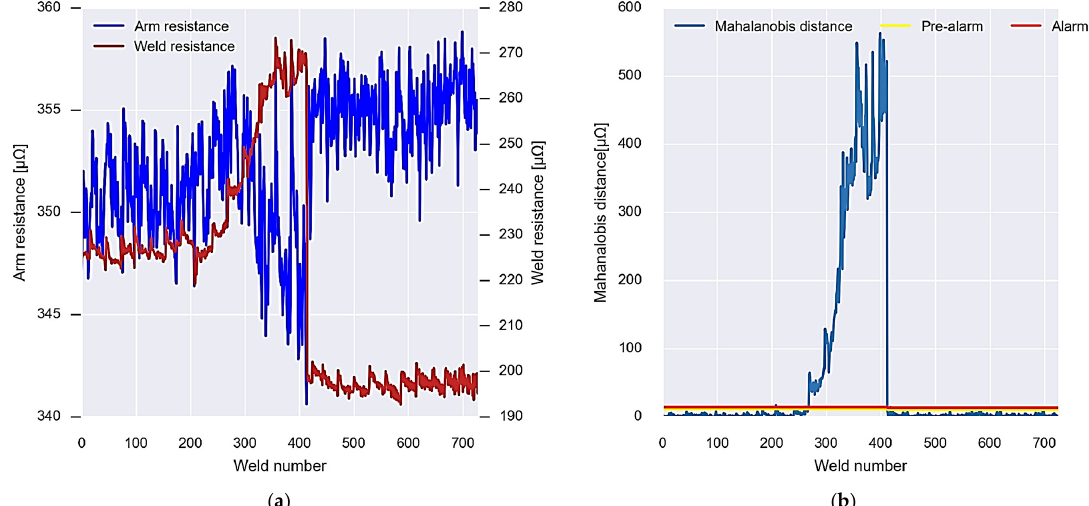
Figure 16. Gun 2 alarm system operation. ( a ) New incoming resistance data. ( b ) Analysis and re-calibration of alarms.